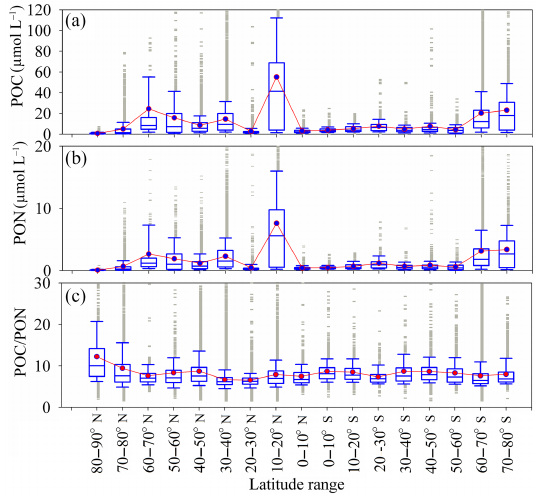
Figure 2. Latitudinal variation of POC (a) , PON (b) and the POC / PON (c) ratio from the compiled statistical results of depth- integrated data for all ocean data. The box plots show the median and 25th and 75th percentiles, with whiskers covering most of the data. The red line with green boxes shows the mean value for each latitudinal range.